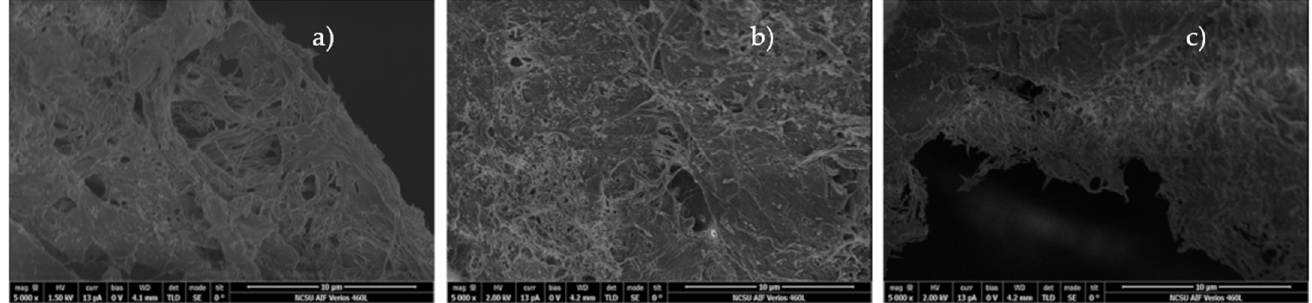
Figure 3. SEM images for chitin after Matsuko grinding ( a ) 5 passes, ( b ) 10 passes, ( c ) 25 passes. The scale bars at the lower right of the left, middle, and right micrographs correspond to 10 µ m. Notice in all passes aggregation was pronounced (a more smooth texture in general).